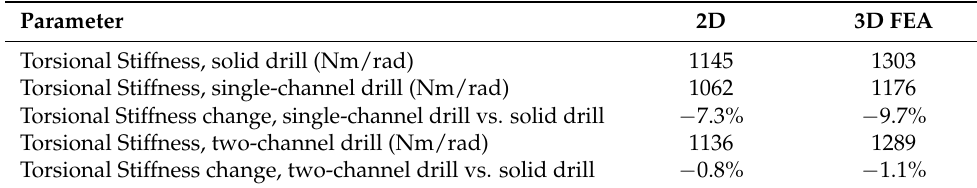
Figure 5. Tangential displacement with 3D FEA for the ( a ) solid drill (max: 9.21 μ m), ( b ) drill with a central channel (max: 10.21 μ m), ( c ) two-channel drill (max: 9.31 μ m). Table 2. Torsional stiffness calculated by the 2D method and 3D FEA.